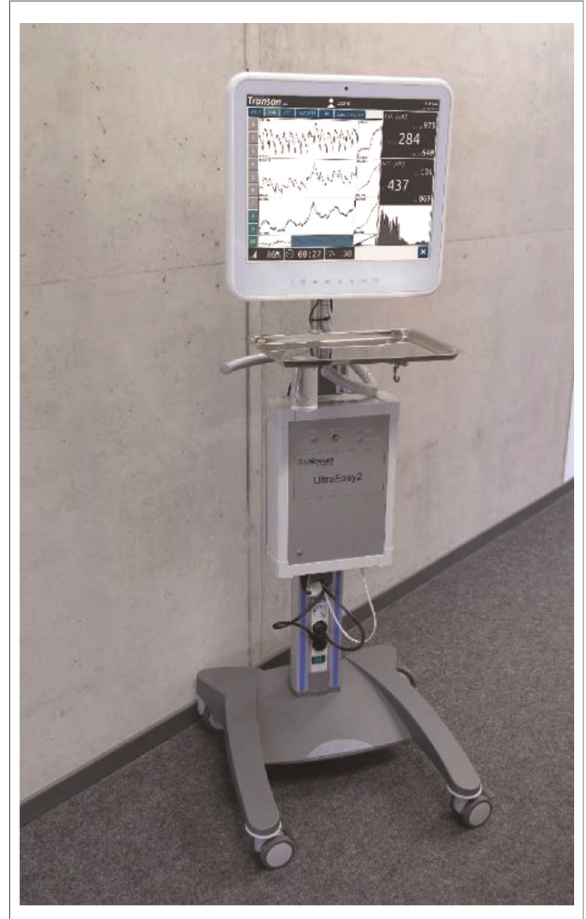
FIGURE 1 UltraEASY2 system used in the study. All components are assembled into a trolley to be transportable. The software component (Transon 2.0) does not give an analysis and is only used for data